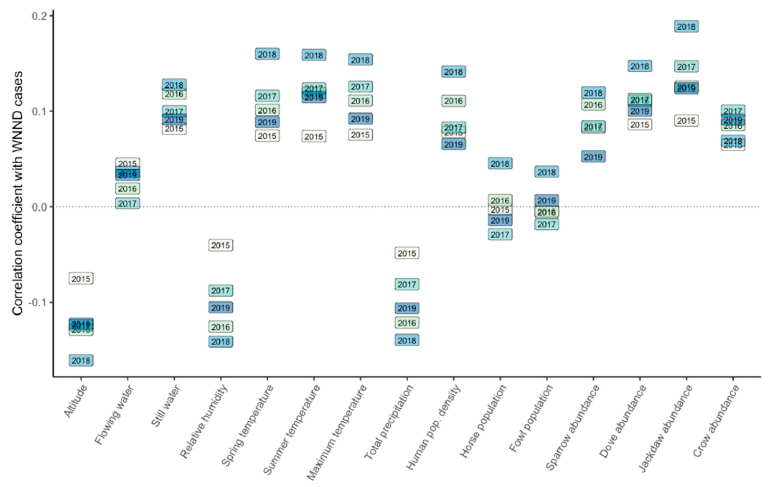
Figure 4. Spearman’s rank correlation coefficient between the number of human WNND cases and the studied predictors for each year.